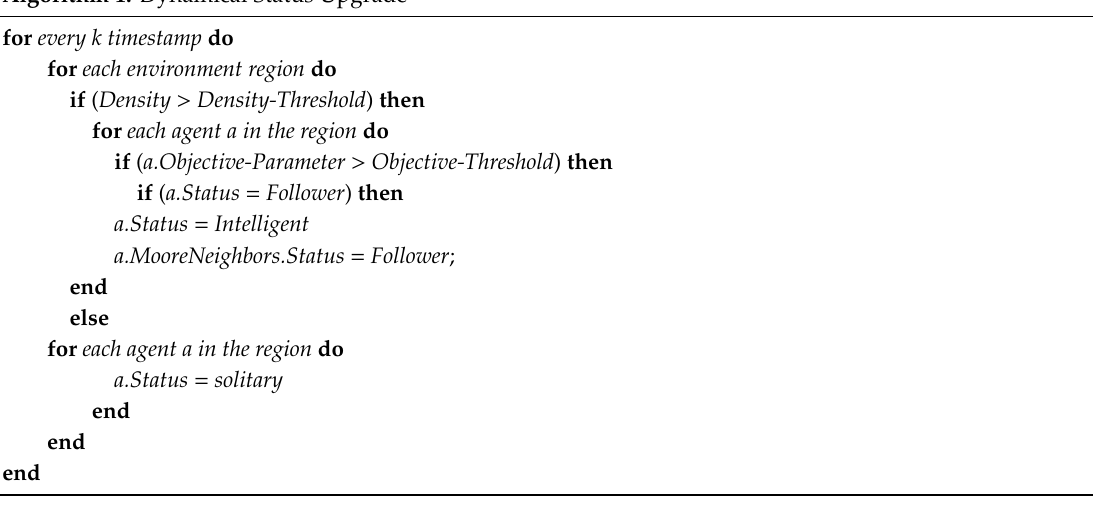
Algorithm 1: Dynamical Status Upgrade